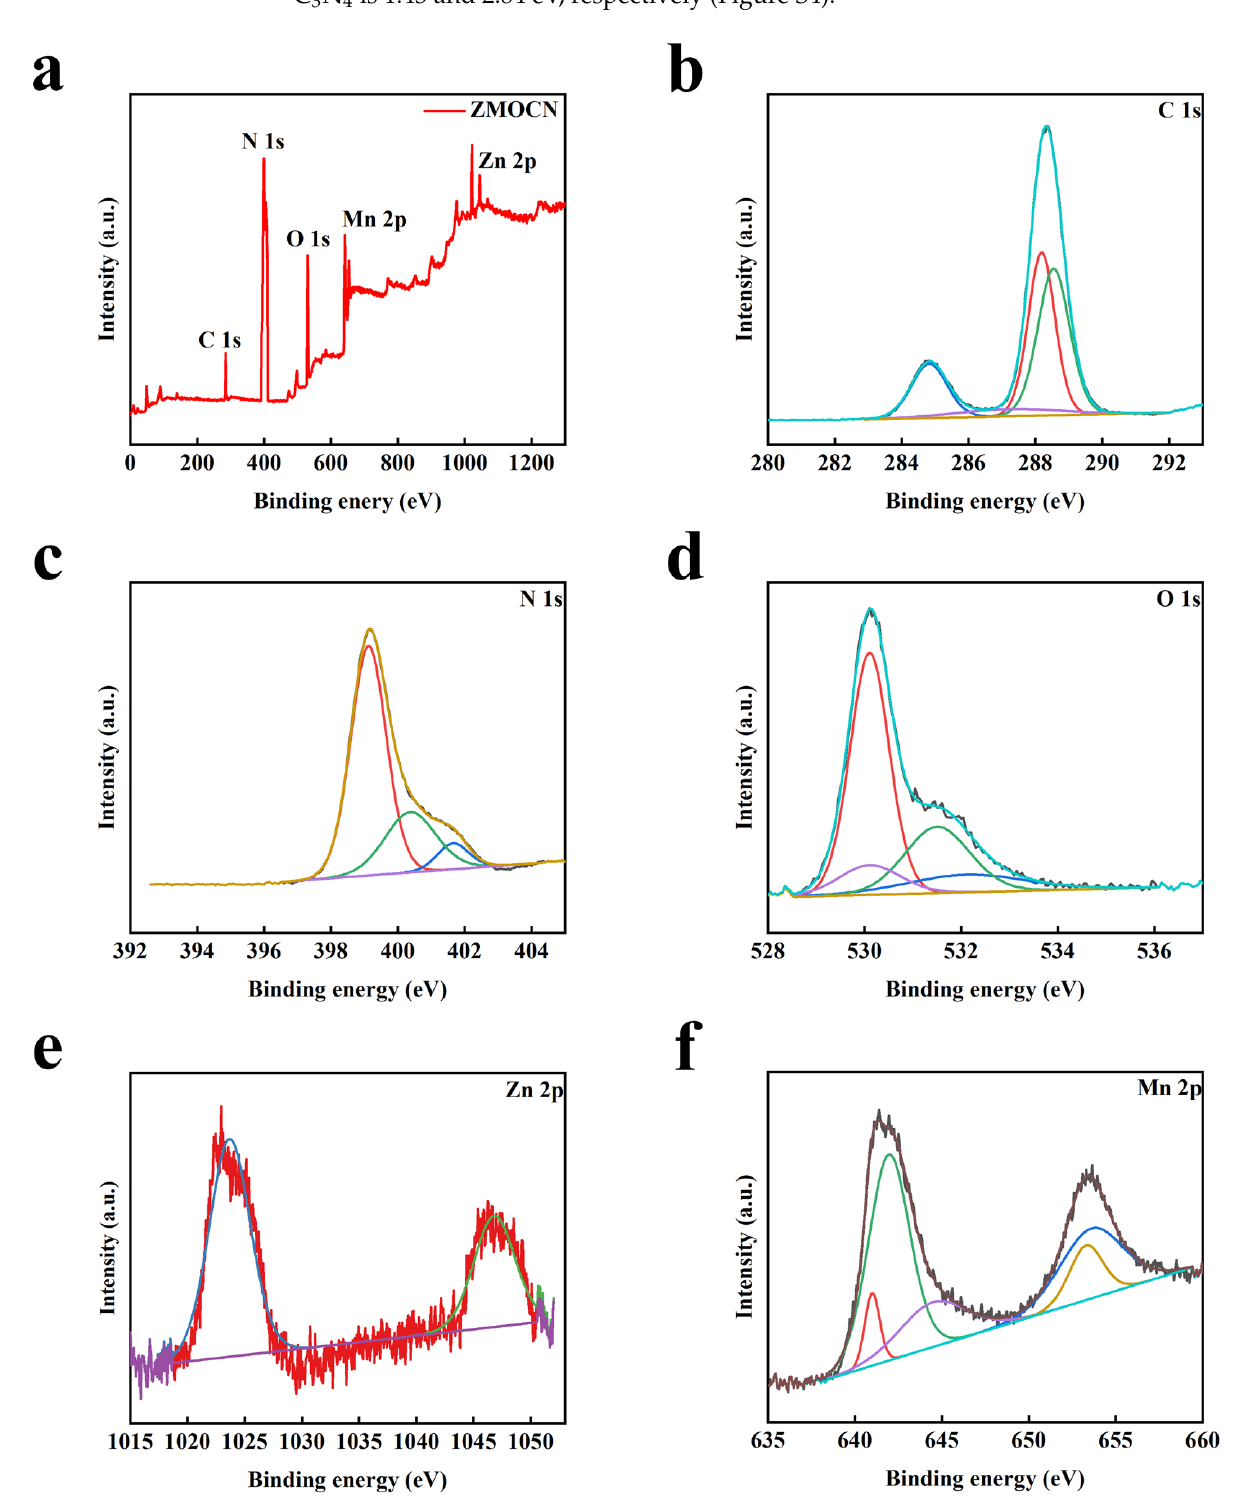
Figure 2. ( a ) XPS spectra of ZMOCN-50 wt%, high-resolution XPS spectrums of ( b ) C 1s, ( c ) N 1s, ( d ) O 1s, ( e ) Zn 2p, and ( f ) Mn 2p of ZMOCN-50 wt%, respectively.